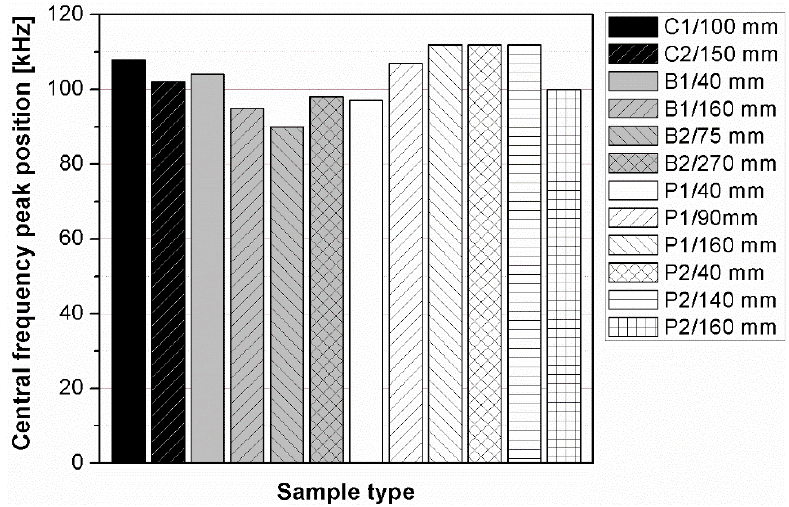
Figure 10. Changes in the position of central frequency peak depending on the sample geometry.